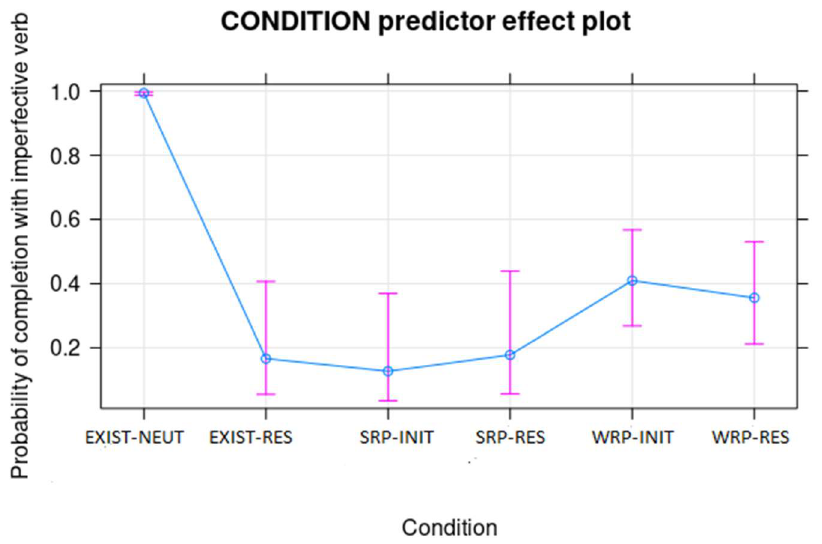
Figure 6. Condition